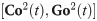
Setup of the experiment with context.E1 receives the feature vectors on the o(t) input and receives the context vector [Co2(t),Go2(t)] from its parent E2, which helps it to resolve uncertainty in the Temporal Pooler. The same holds for higher level(s).